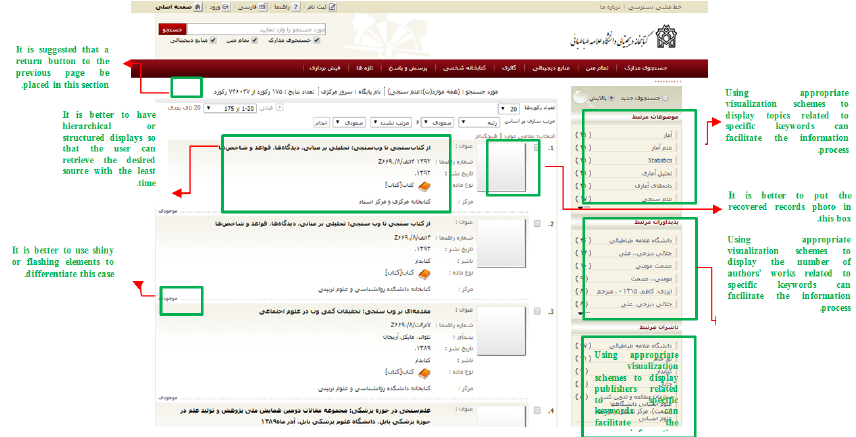
Figure 6- The proposed pattern of findings page of the Digital